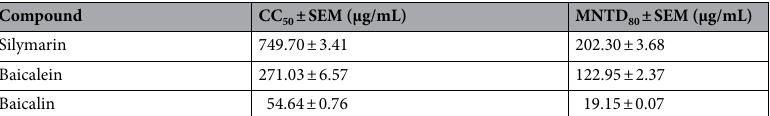
Table 1. Cytotoxicity of flavonoids against Vero cells. Different concentrations of silymarin, baicalein, and baicalin were tested for cytotoxicity in Vero cells by MTS assay. CC 50 refers to the half maximum cytotoxic concentration, whereas MNTD80 is the dose at which 80% of the cells are viable. Data were acquired from three independent experiments and presented as mean ± standard error mean